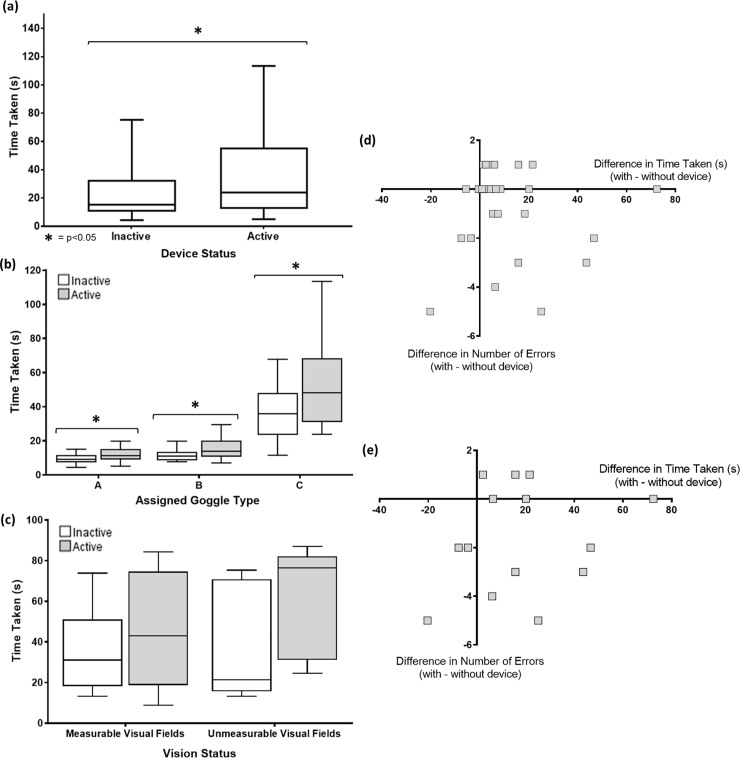
Time taken to complete mazes.Time taken to complete the mazes increased when using the LEO Belt compared to without the LEO Belt. This occurred for all subjects regardless of the stage of reduced peripheral vision (p<0.001) (a). Sighted subjects were slower when using the device (grey) whilst wearing goggle A (p = 0.002), goggle B (p = 0.017) and goggle C (p = 0.018) compared to without (white) (b). The mean increase in time taken was greater for visually impaired subjects with unmeasurable VFs compared to measurable VFs (c). Time taken was not significantly correlated with number of errors made by sighted subjects (p = 0.694) (d). This was also true when focusing only on those wearing goggle C (p = 0.47) (e).